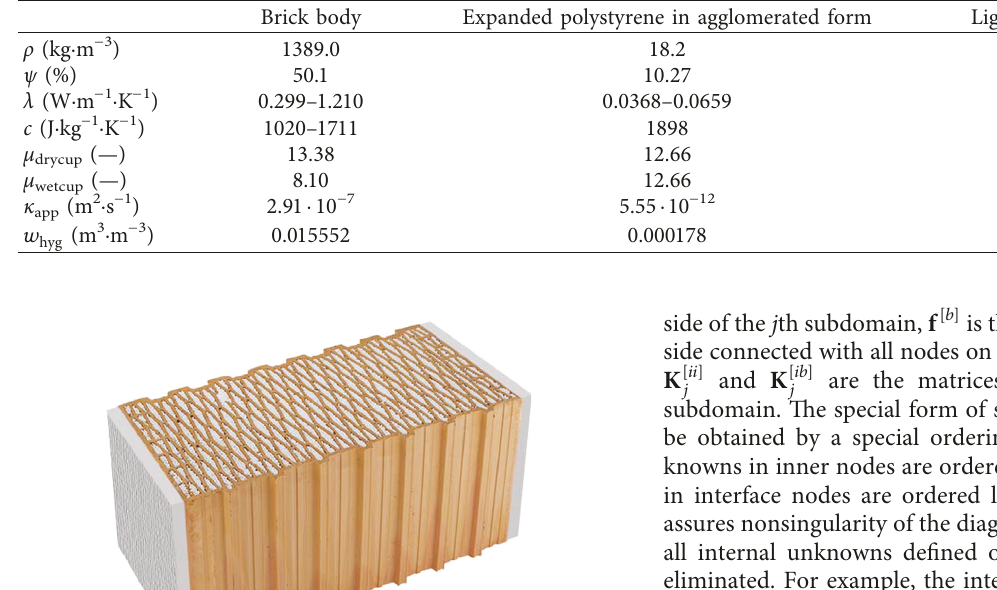
Table 1: Properties of particular